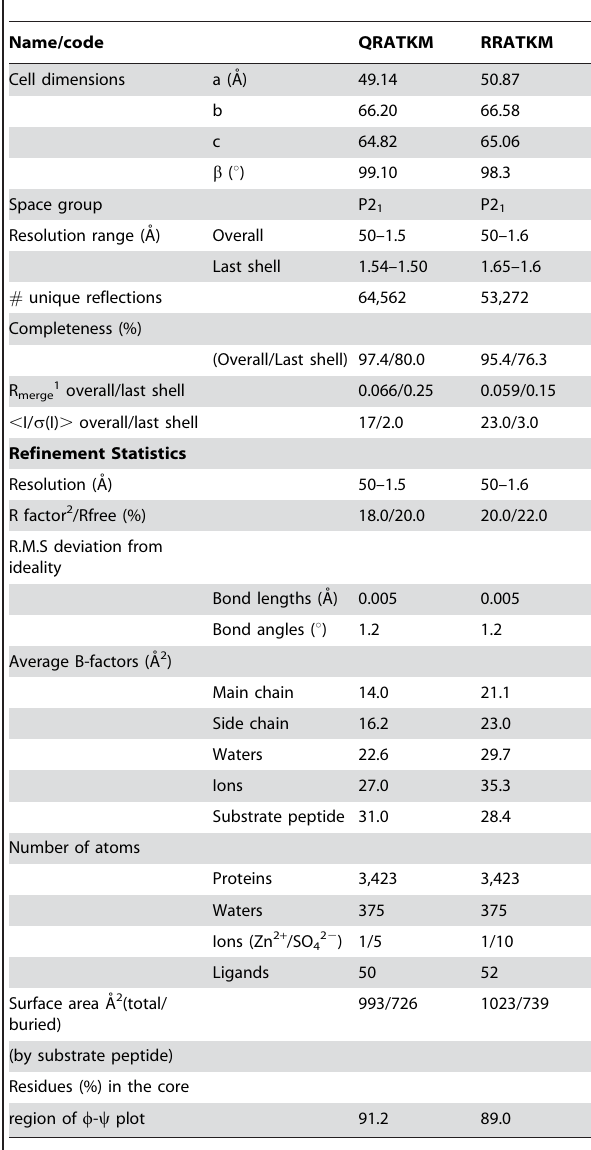
Table 1. Crystal data and refinement statistics of